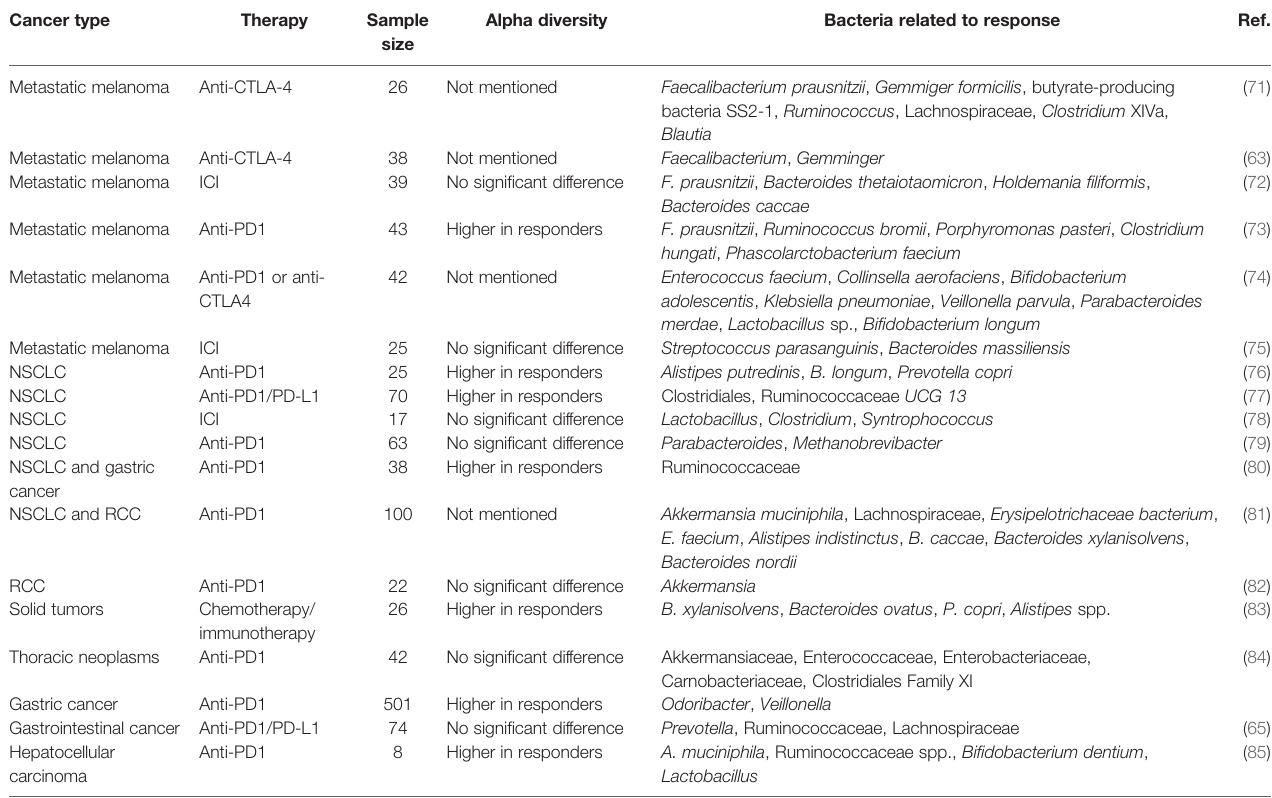
TABLE 1 | Clinical evidence linking gut microbiota and cancer